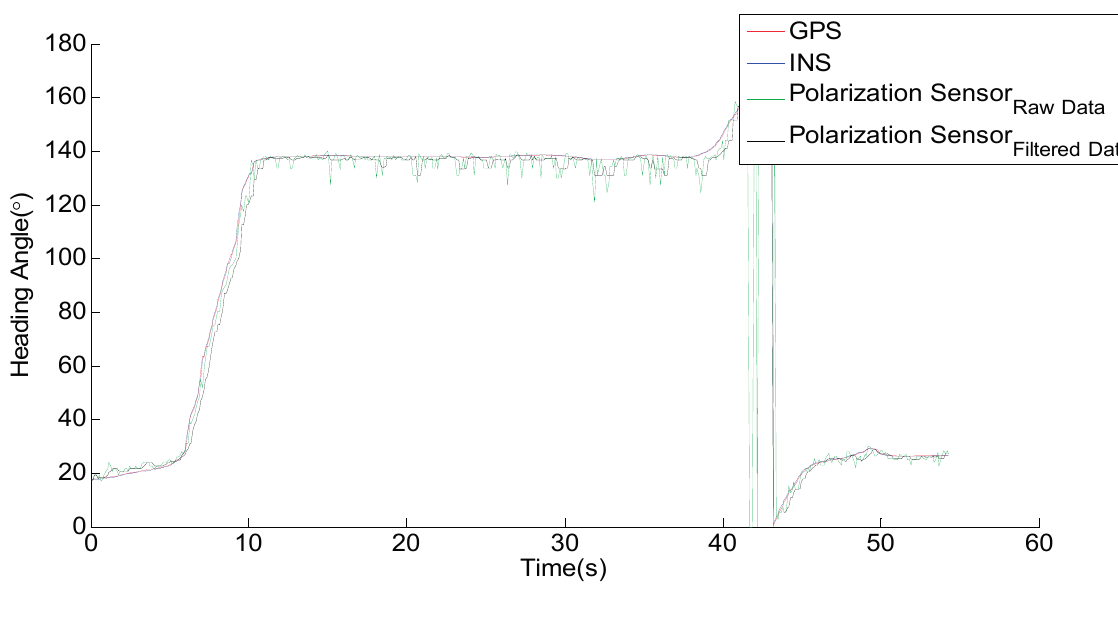
Figure 13. The result of GPS, INS and the polarization